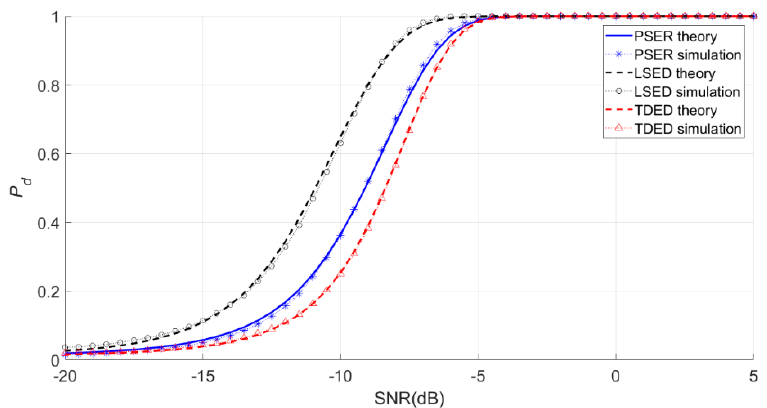
Figure 14. Actual false alarm probabilities obtained by three methods for the Ricker wavelet with local bandwidths of 36–65 Hz.